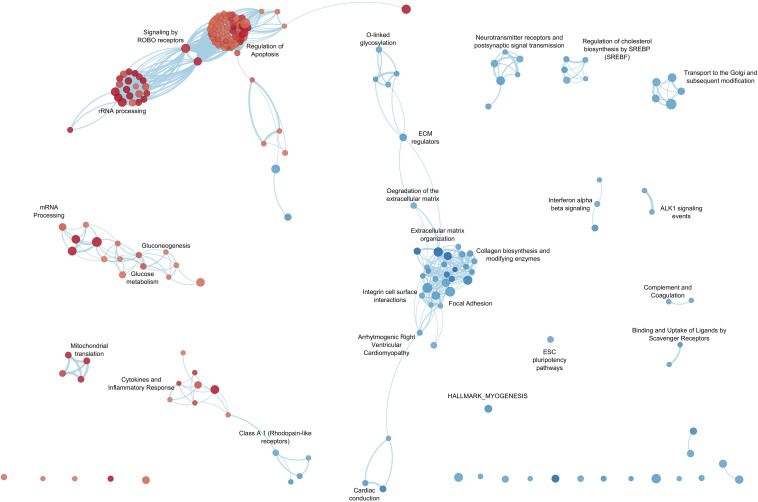
Enrichment map for left ventricle (LV) and right ventricle (RV) cardiac mesenchymal stromal cells (C-MSC). The enrichment network shows the pathway gene sets (nodes) that are significantly associated either with LV or RV ventricles (false discovery rate < 0.05). Node color refers to the association with the phenotype (LV = red, RV = blue); node gradient color is proportional to the gene-set normalized enrichment score (NES), from lower (light) to higher (dark); node size is proportional to the gene-set size. Edges connect related pathways. Edge thickness is proportional to the similarity between two pathways, for a cutoff = 0.25 of the combined Jaccard plus overlap coefficient.